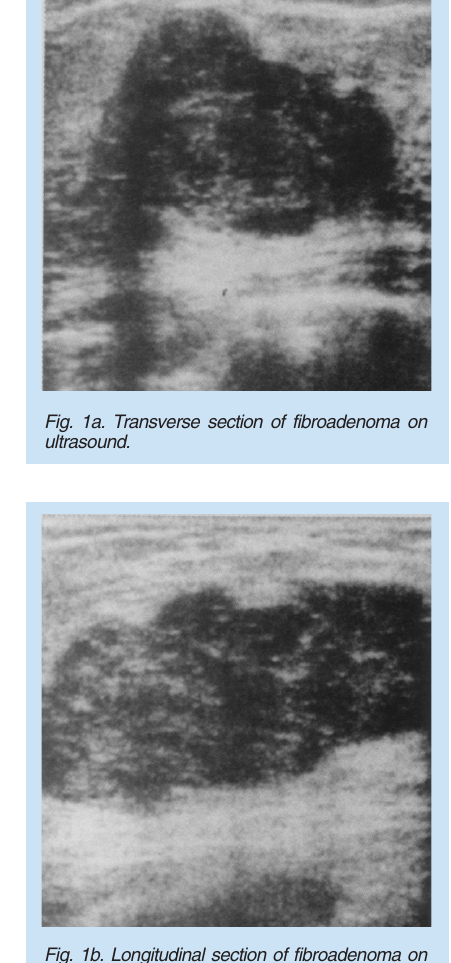
Fig. 1b. Longitudinal section of fibroadenoma on